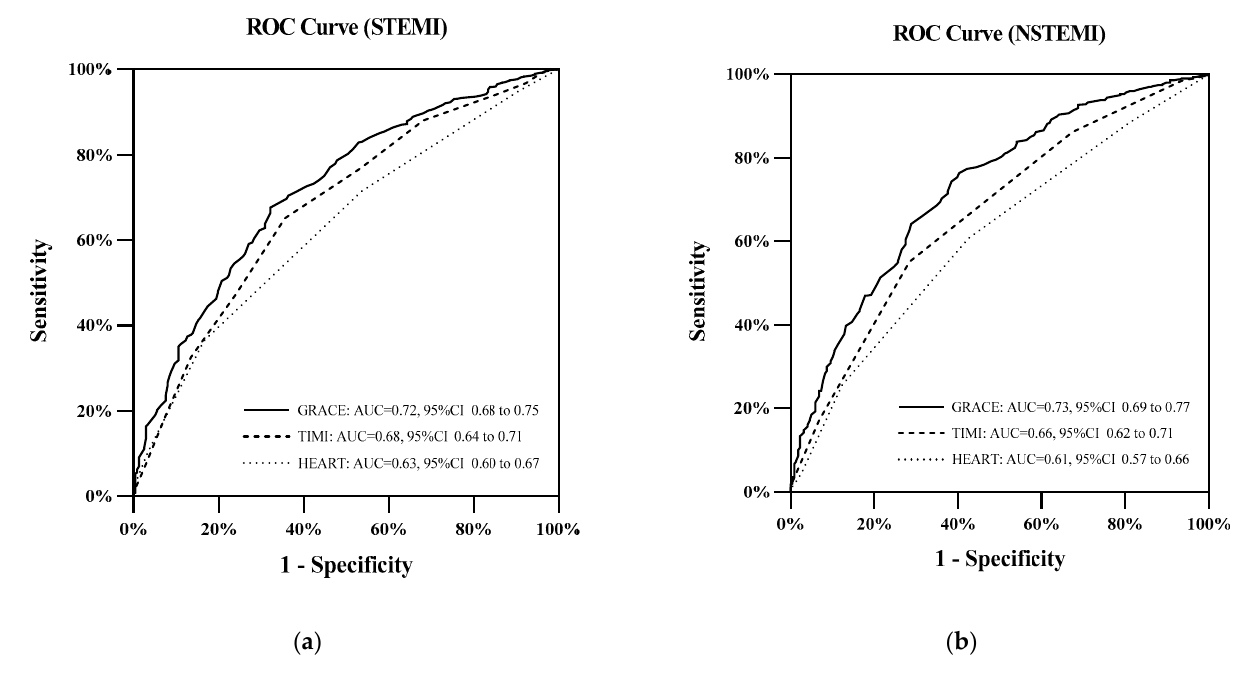
Figure 3. ( a ) ROC curves for the three risk scores in STEMI patients at the end of follow-up. ( b ) ROC curves for the three risk scores in NSTEMI patients at the end of follow-up.